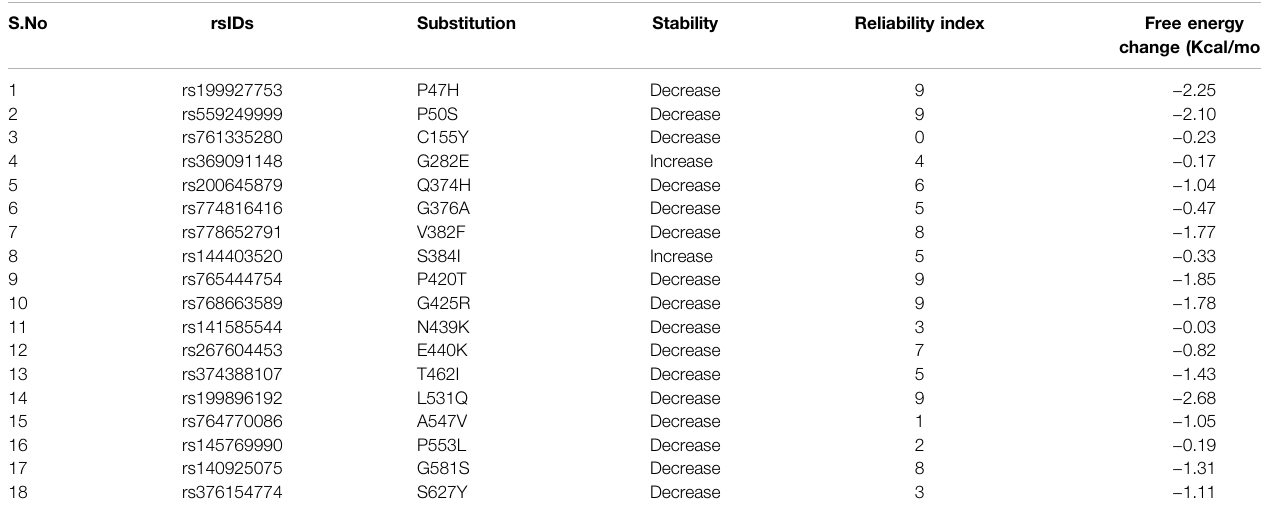
TABLE 3 | I-Mutant2.0 results for the selected 18 deleterious nsSNPs.